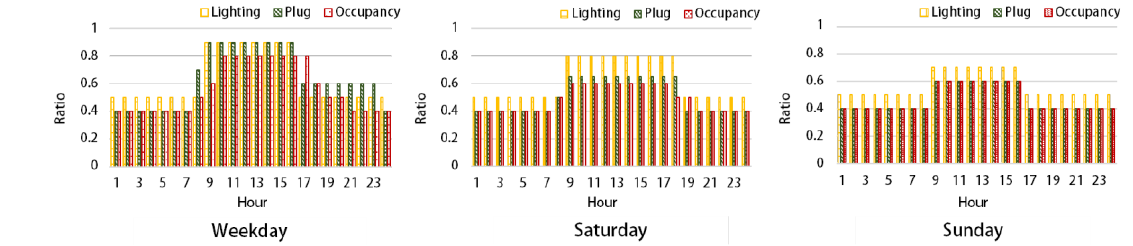
Figure 5. Occupancy, lighting, and equipment schedules of the hospital building. Table 2. Summary of the hospital.